Question: In a single sentence, describe what this figure presents.
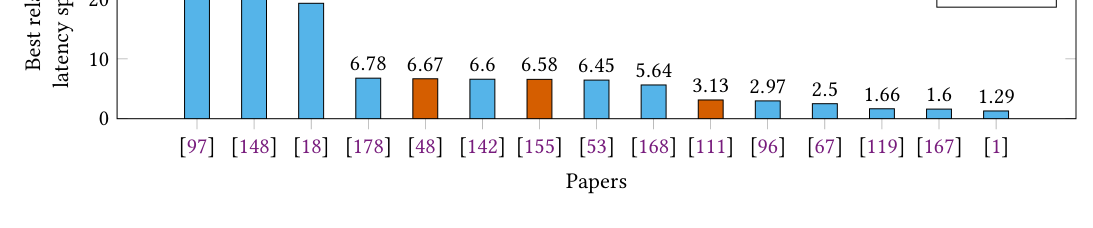
Answer: Best latency speedup (when compared against the case with only one edge device) reported for papers using horizontal partitioning